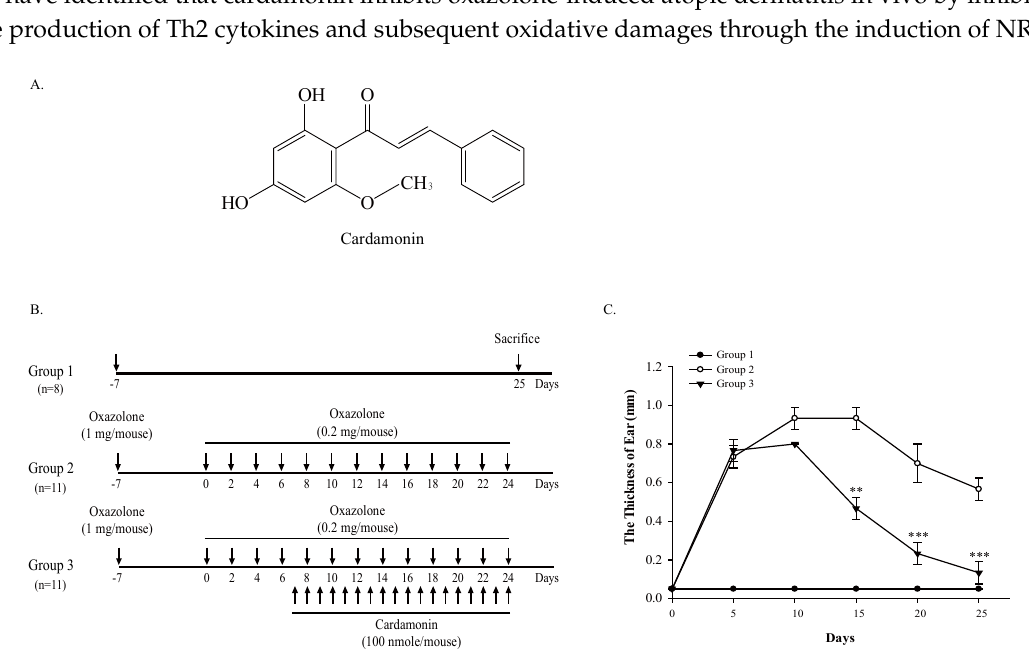
Figure 1. Cardamonin suppresses oxazolone-induced inflammation in mouse skin. ( A ) Chemical structure of cardamonin. ( B ) Experimental scheme evaluating the effect of cardamonin on oxazolone-induced atopic dermatitis. ( C ) Cardamonin inhibits oxazolone-induced inflammation in mouse skin. The thickness of ear in mice was measured using a caliper every five days. Asterisks indicate a statistical significance of ** p < 0.01 and *** p < 0.001.